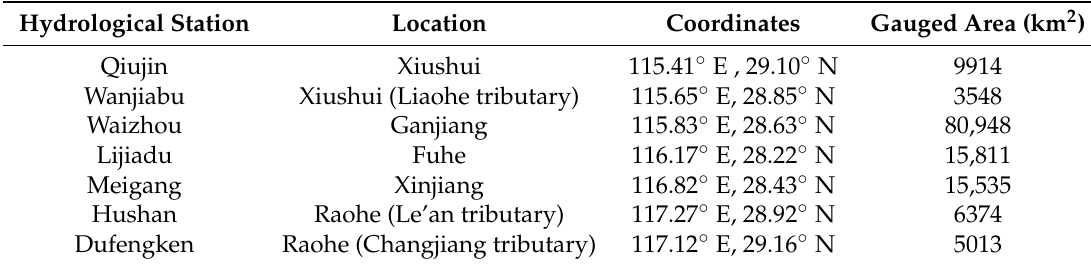
Table 1. List of hydrological stations used in this study.